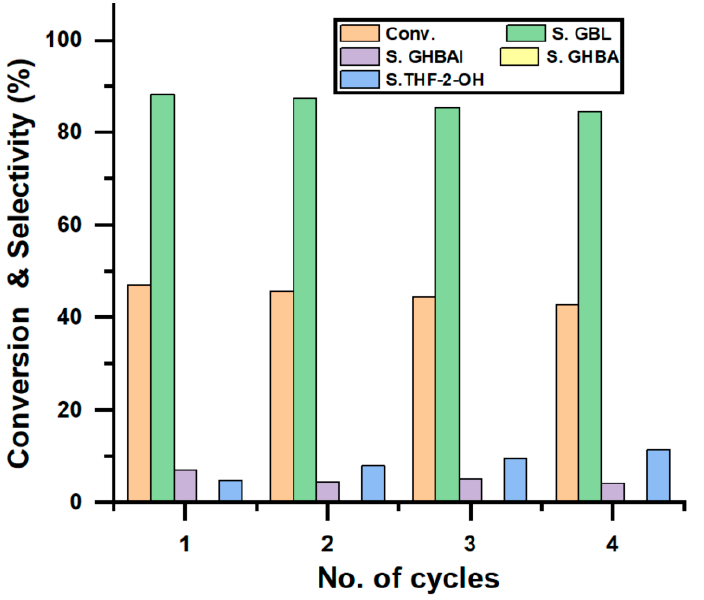
Figure 14. Reusability of ZFNPs. Reaction conditions: H 2 O 2 = 0.1 mol, THF = 0.1 mol, 80 °C, 9 h, and 0.5 g of catalyst.